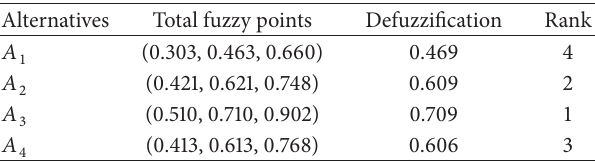
Table 6: Crisp values and sequences of the alternative suppliers’